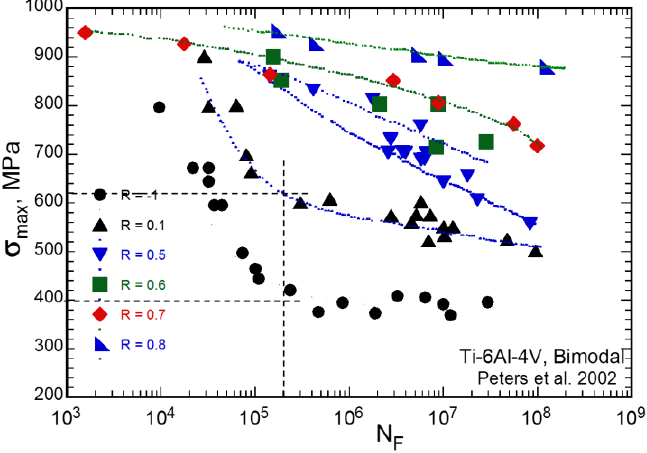
Figure 2. S-N data for Ti-6Al-4V alloy plotted in terms of σ fail for various constant R -ratios